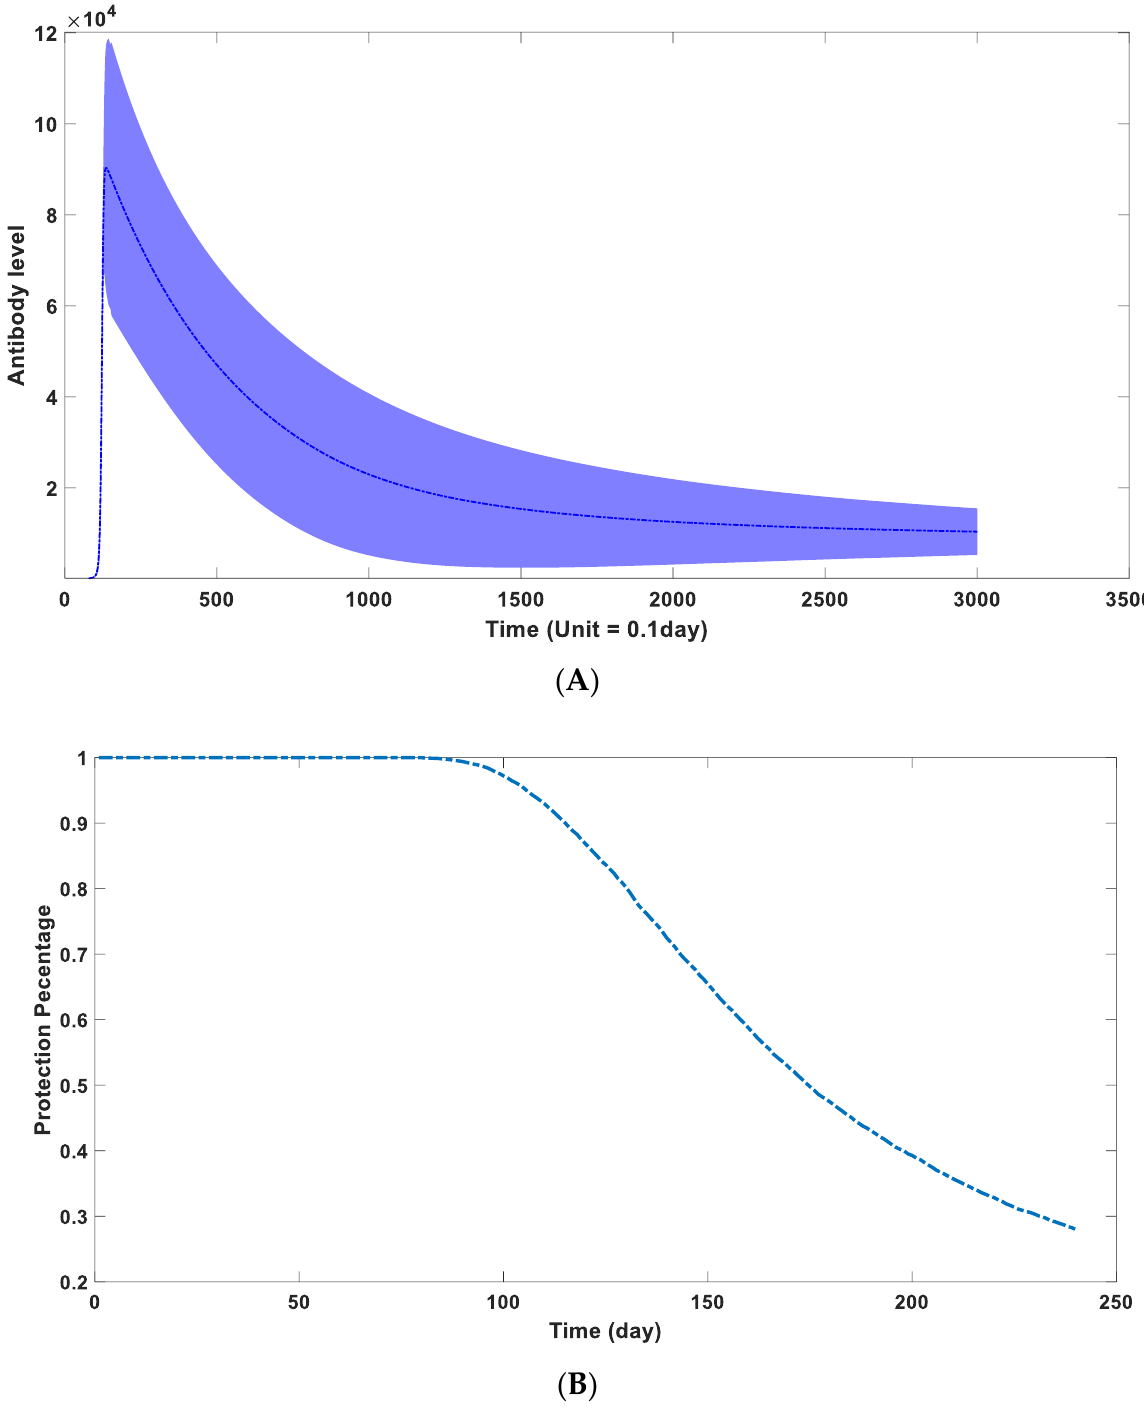
Figure 10. ( A ) the dynamic behavior of antibodies in the overall population through time. (The blue zone around mean curve stands for 95% confidence interval). It can be seen that the IgG level would significantly decline after reaching a peak level. However, its degradation does not follow a simple mathematical formula. Its descent rate would gradually decline and be maintained at a relatively stable level after 200 days. ( B ) The protection performance of antibodies in the overall population through time. It can be seen in this figure that the protection efficiency of induced neutralizing antibodies would be maintained at a relatively high level in the first 100 days. Its protection efficiency would engage a rapid decline after the first three months.